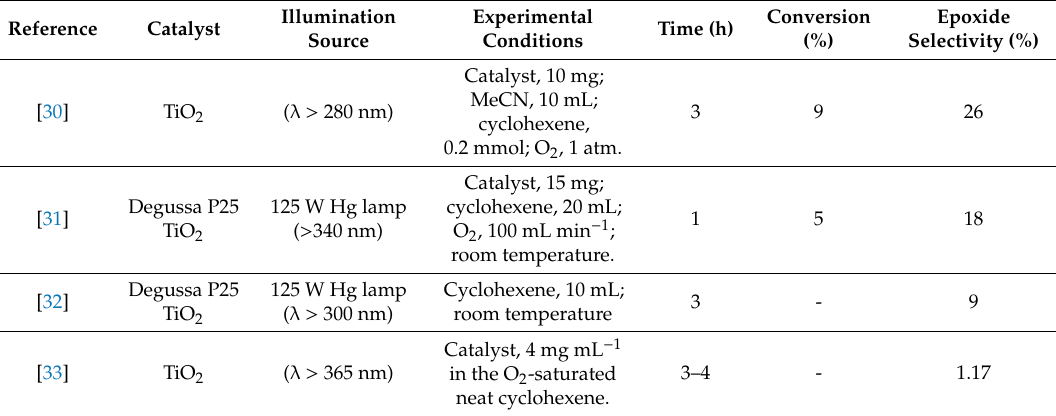
Table 1. Reported studies on the selective photocatalytic oxidation of cyclohexene over TiO 2 -based